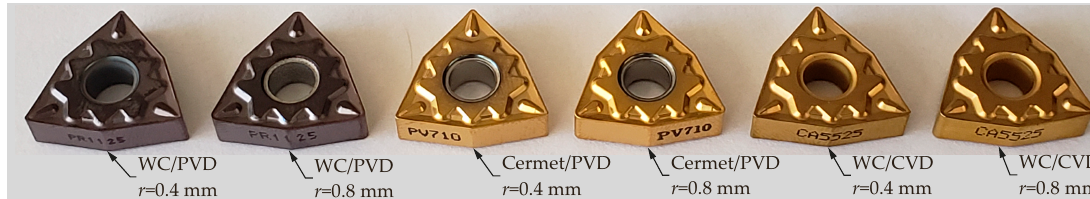
Figure 3. Turning inserts used in the experiments.